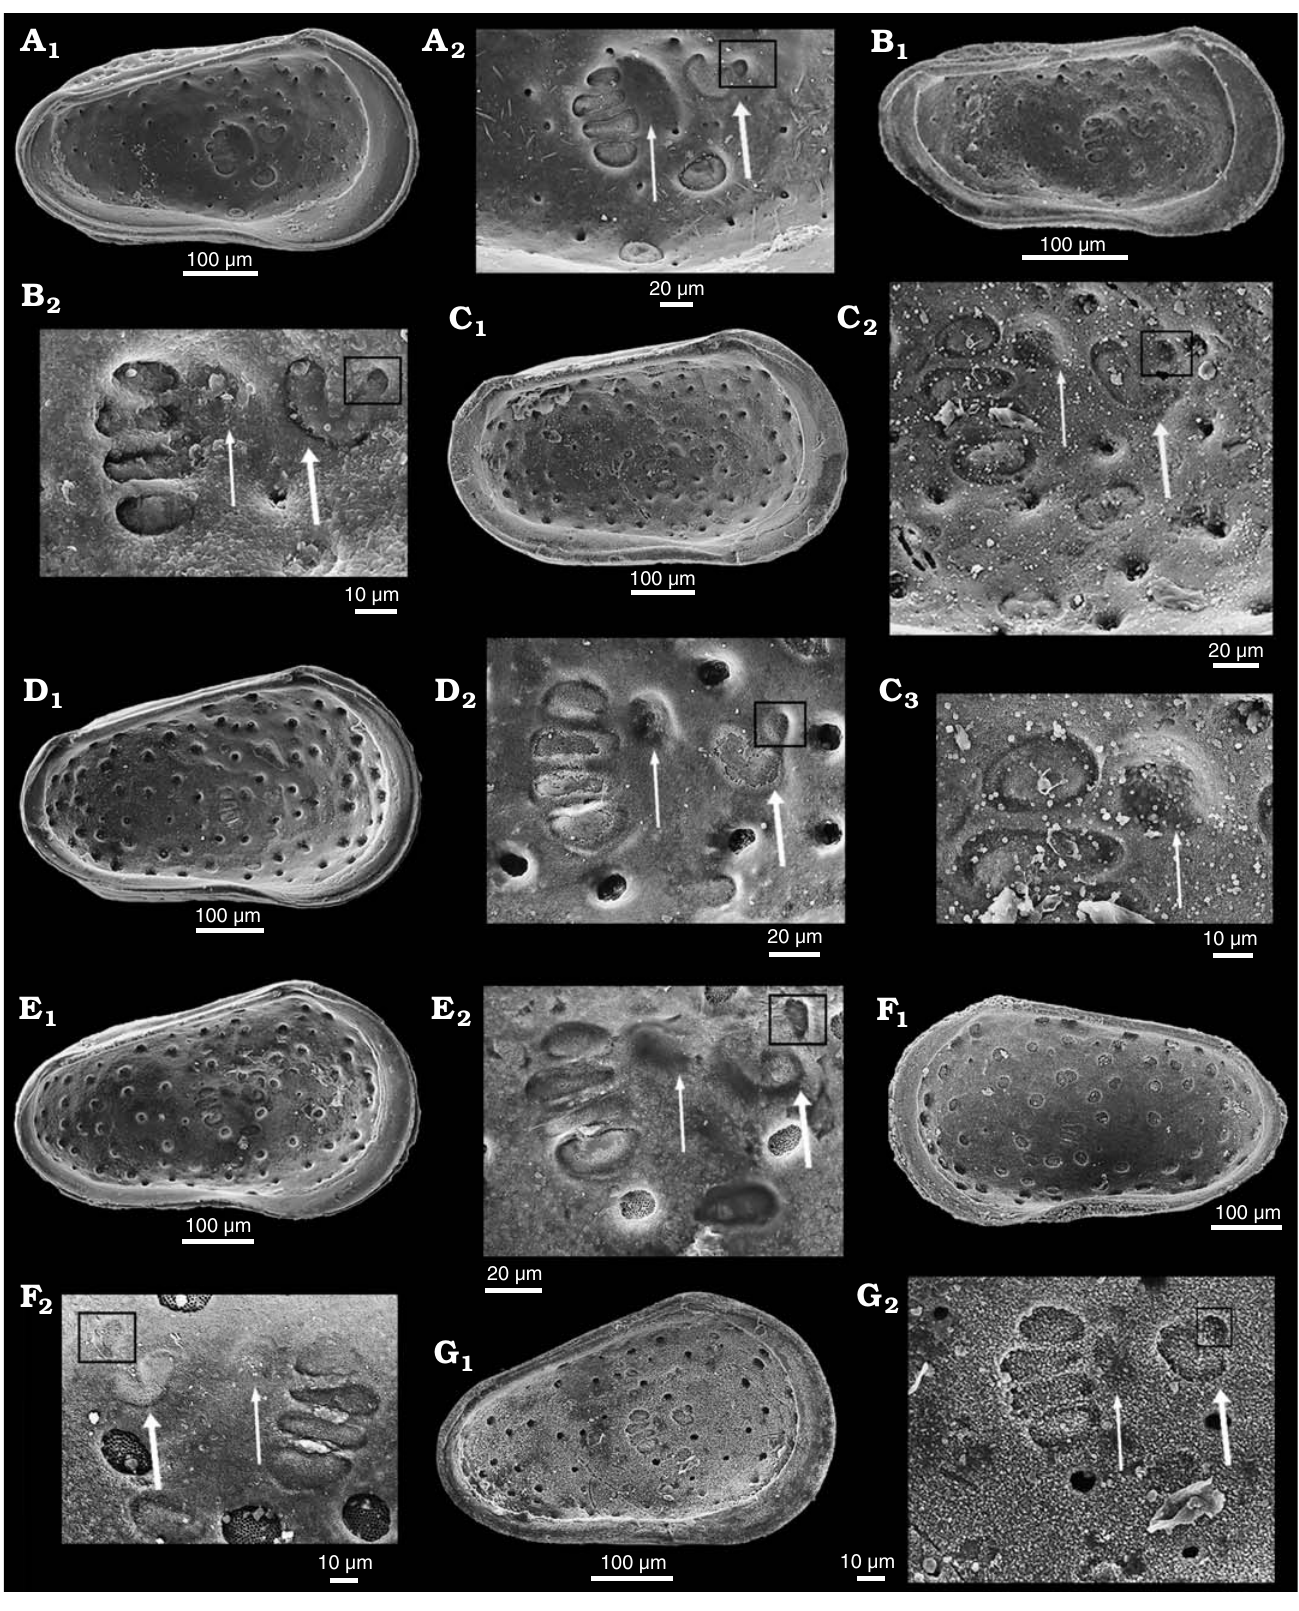
Fig. 5. Comparison of valve morphology and muscle scars in cytherid ostracods Dolocythere (A, B) and Minyocythere (C–G). A . Dolocythere rara Mertens, 1956 from Borehole Lingen 196, 697–704 m, NW Germany, Lower Albian. Paratype, BGR T.-K. 1300 (Mertens Collection, Hannover), female left valve in internal view (A 1 ), detail (A 2 ). B . Dolocythere amphistiela sp. nov. from Borehole Rodewald WA4, 187 m, NW Germany, lower Middle